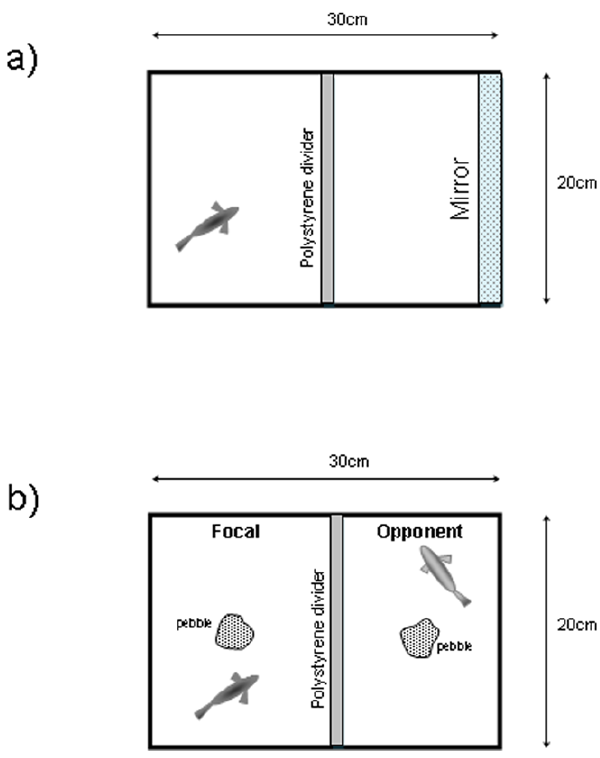
Figure 1. Above view of experimental tank set ups for start of (a) mirror tests and (b) dyadic interaction tests. Polystyrene dividers were removed at the start of each trial.